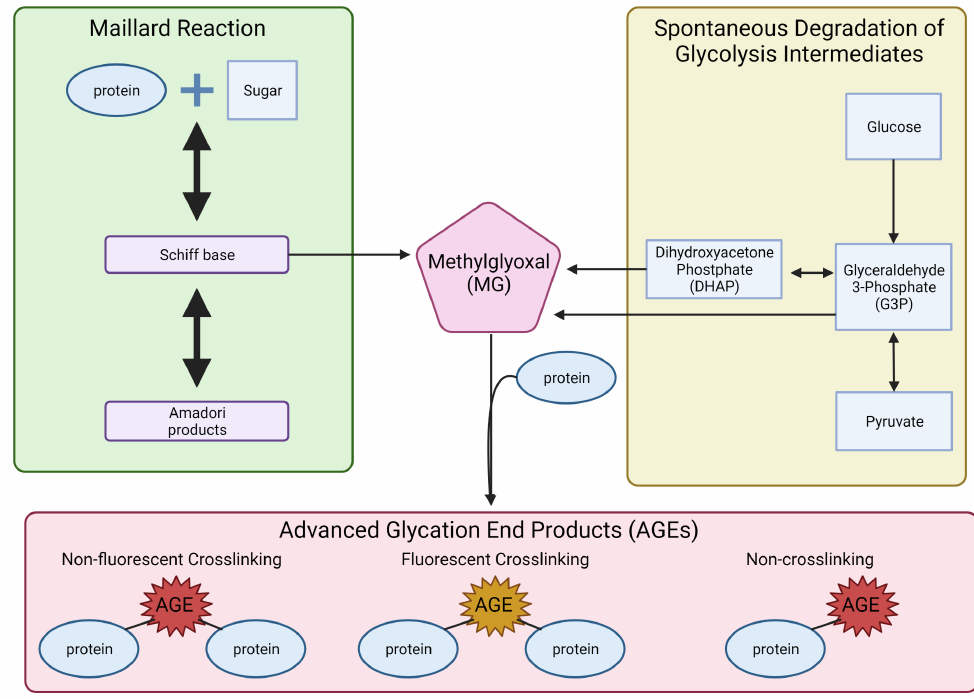
Figure 5. Formation of the advanced glycation end products. The illustration displays two pathways: Maillard reactions and the spontaneous degradation of glycolysis intermediates that lead to the formation of three types of advanced glycation end